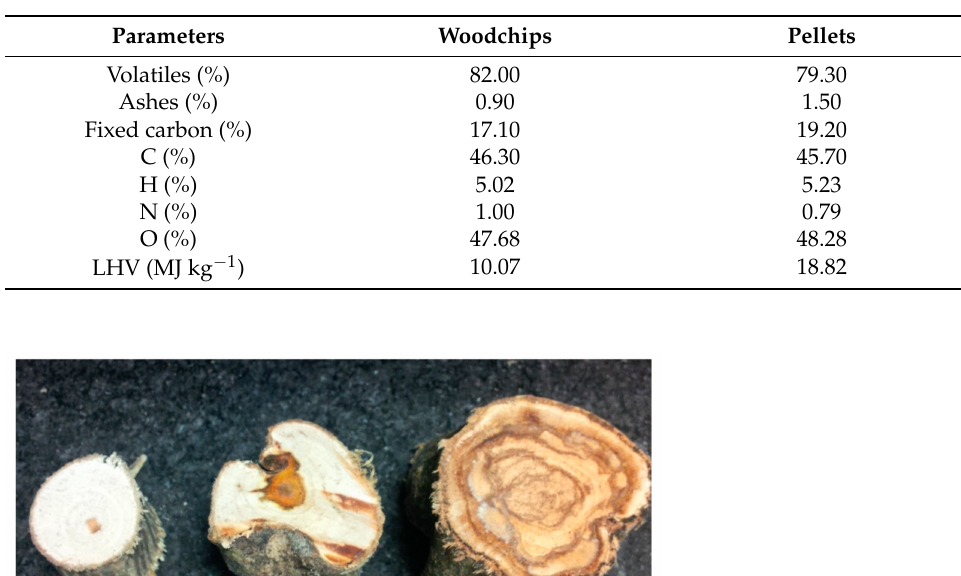
Table 1. Laboratory characterization of woodchips and pellets of C. striatus .